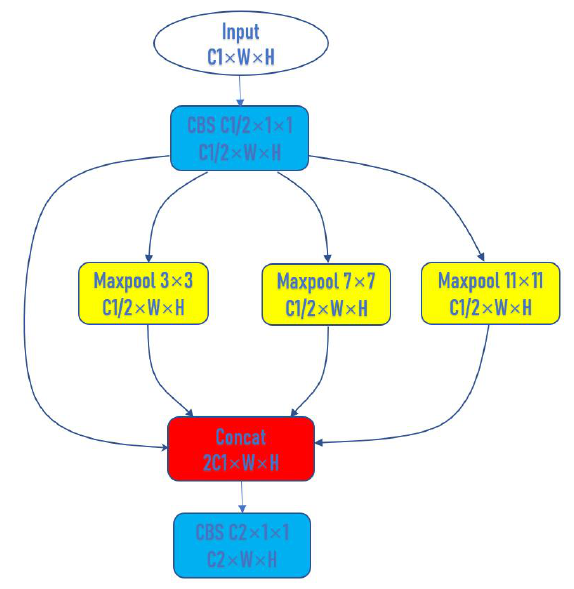
Figure 3. Structure of the